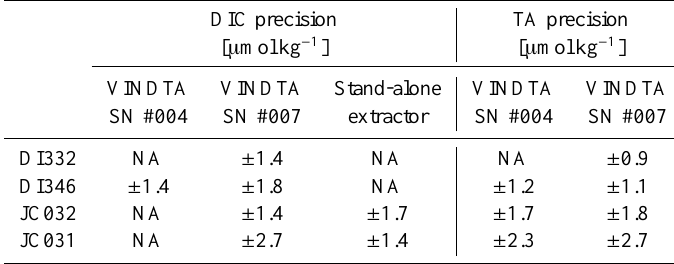
Table 4. Precision of DIC and TA measurements, defined as the standard deviation of in-bottle duplicate measurements during DI346, JC032, and JC031, and of same-depth duplicate measurements during DI332.